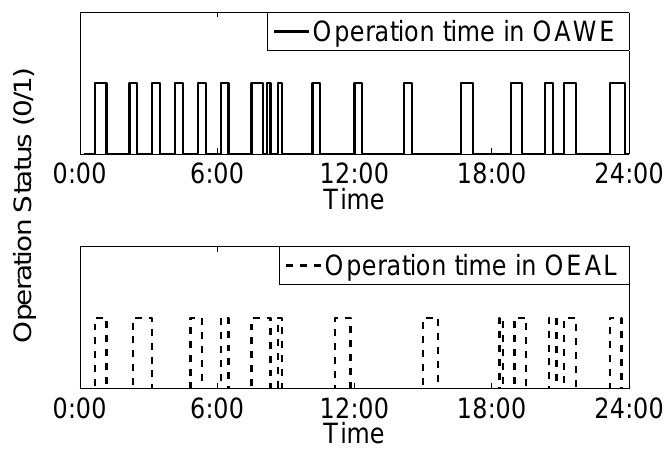
Figure 14. Comparison of the operation time for HVAC between OAWE and OEAL.